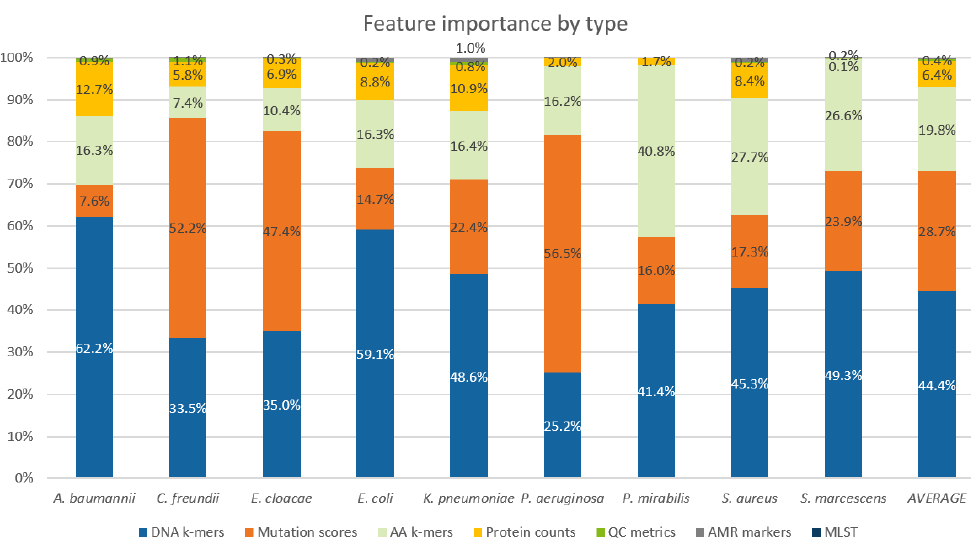
Figure 3. Relative importance of different feature types for individual pathogens as measured by SHAP contributions of features to model output. Values were summed up across all tested compounds.